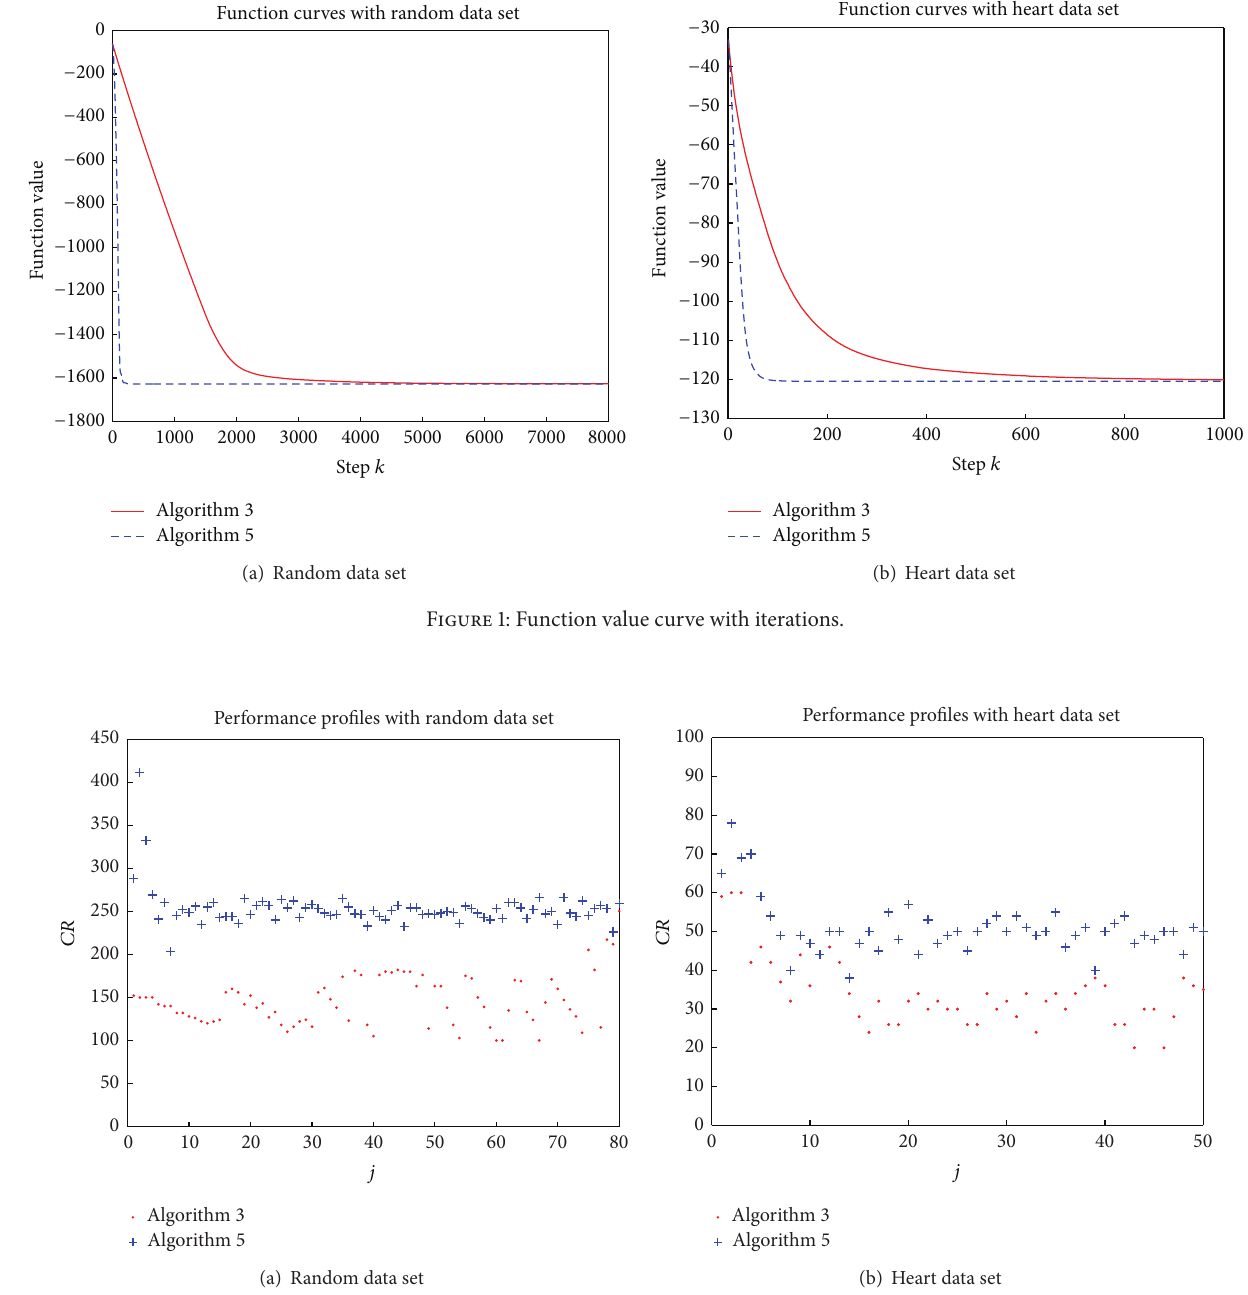
Figure 2: Number of calculating 𝑟(𝜆) for every finite